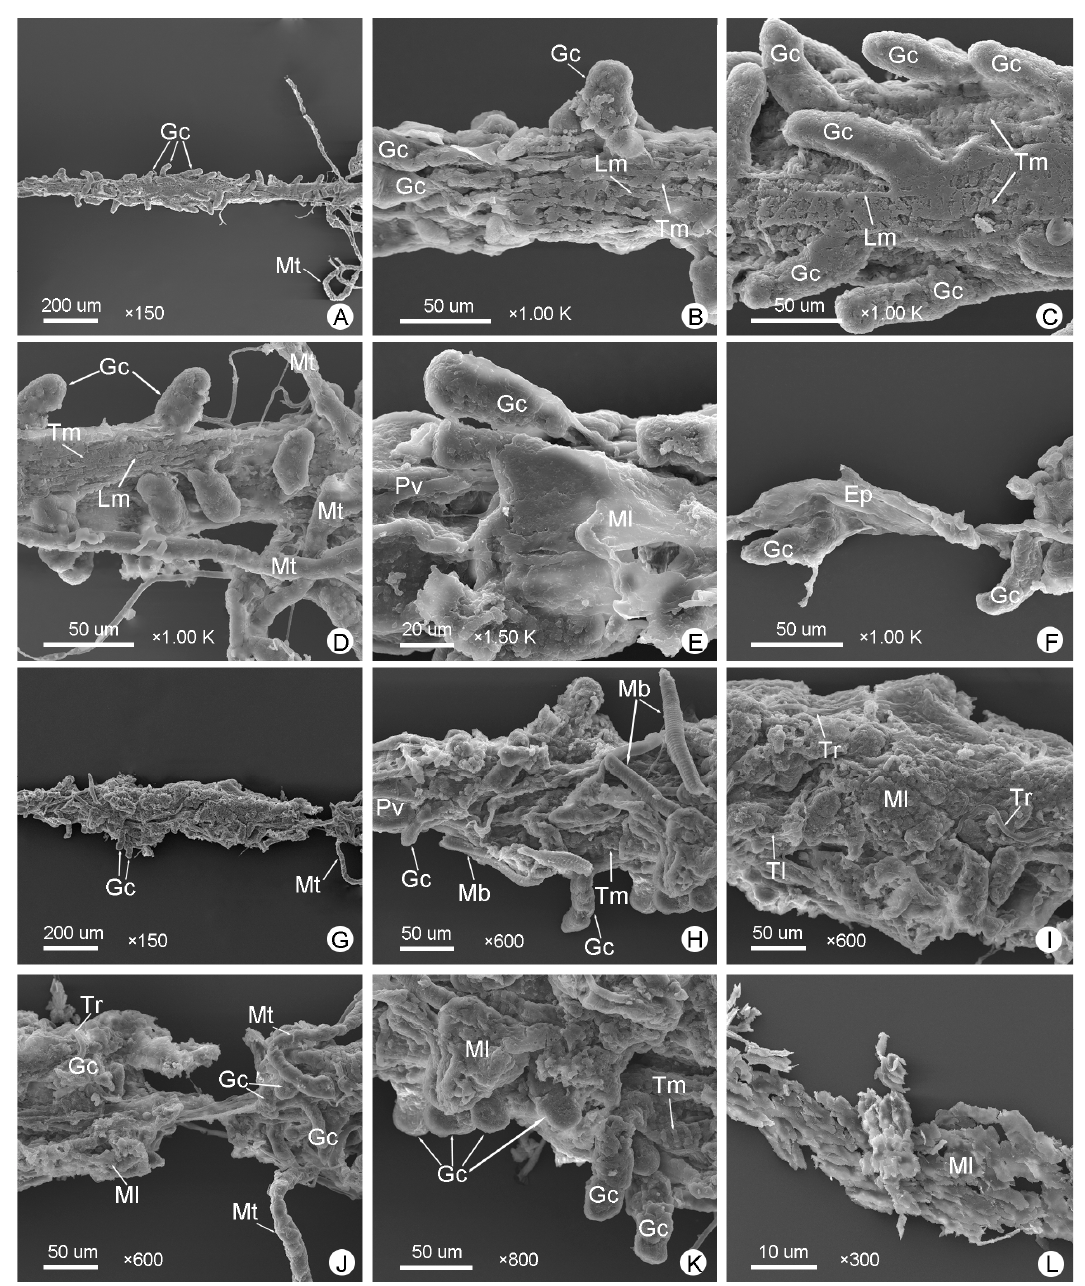
Figure 6. The midguts of M . ( O .) chinensis (males ( A – F ), females ( G – K )): ( A , G ) general view of the midgut; ( B , H ) anterior midgut; ( C , I ) middle midgut; ( D , J ) posterior midgut; ( E ) junction of foregut and midgut; ( F ) epithelium (Ep) of the midgut; ( K ) the muscle layer (Ml) wrapping the midgut; ( L ) part of the muscle layer that wraps the midgut was dissected. Gc: gastric cecum, Lm: longitudinal muscle, Mb: muscle bundle, Mt: Malpighian tubule, Pv: proventriculus, Tl: tracheole, Tm: transverse muscle, Tr: